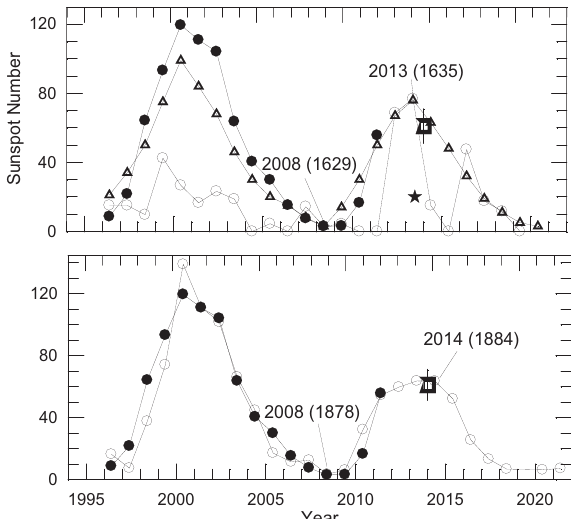
Fig. 8. The open square is our improved prediction of sunspot maximum for cycle #24, viz. 62 ± 12 sunspot numbers, with its estimated error (vertical line). The filled and open circles are taken from the data of Figure 4, but they have been shifted ahead by 378 and 130 years for the upper and the bottom panels, respectively. In the upper panel we have added Nagovitsyn’s (2006) annual sunspot number time series (taken from http://www.gao.spb.ru/database/ esai/)(triangles), shifted ahead by 378 years and Vaquero et al. (2010) data (black star). In 1629 and in 2008 (upper panel) there was a transition to another Grand Episode, viz. to the Maunder Minimum and to the forthcoming Grand Episode, respectively. In contrast, the year 1878 (bottom panel) was within the 1724–1924 Regular